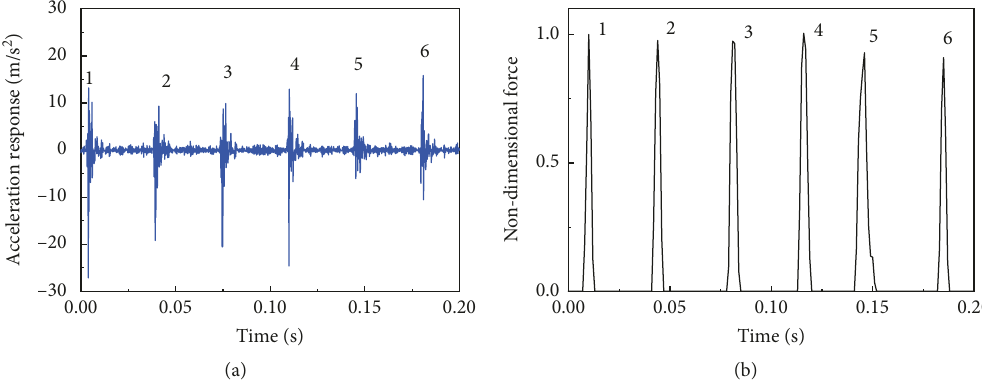
Figure 10: Acceleration response and nondimensional force on the rubbing ring under light rub-impact condition. (a) Experimental acceleration response. (b) Numerical nondimensional force.